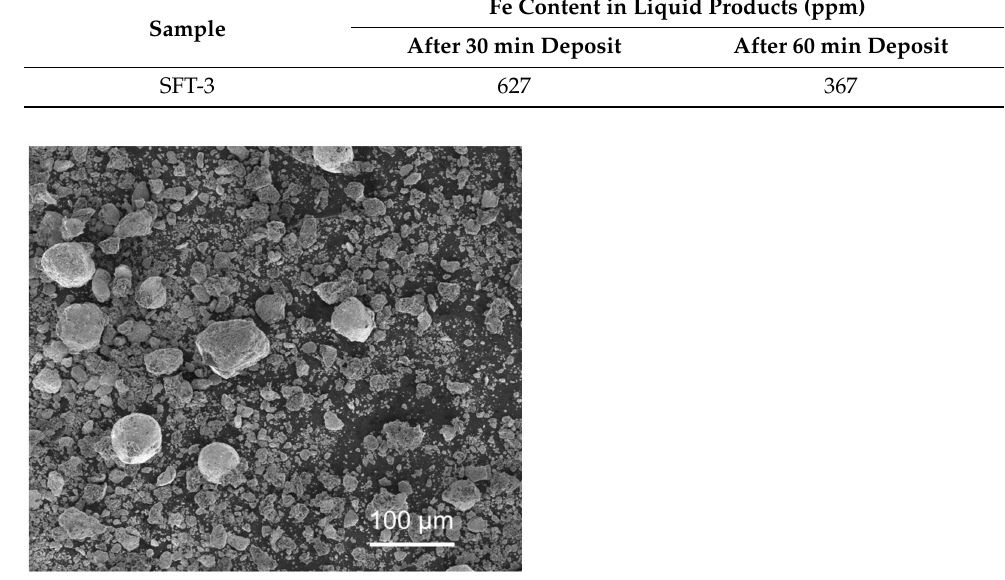
Figure 2. SEM image of SFT-3 after attrition test in slurry bed